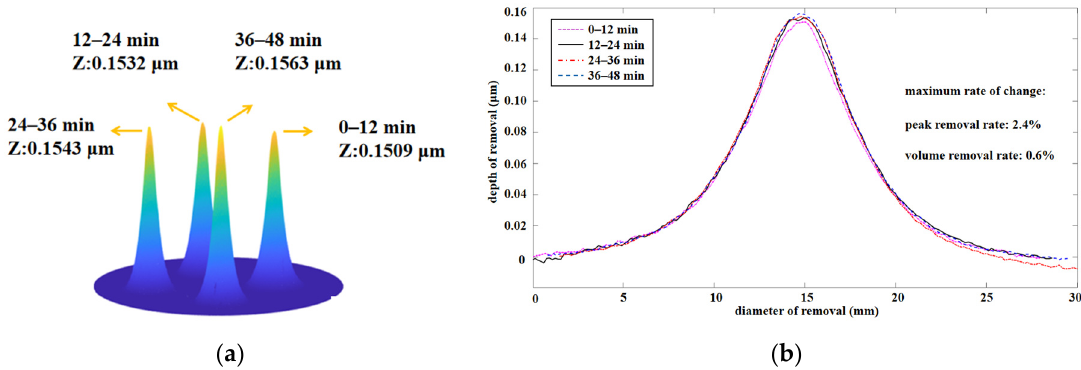
Figure 8. Time stability of the LPIB: ( a ) removal depth; ( b ) removal depth curve of each period.